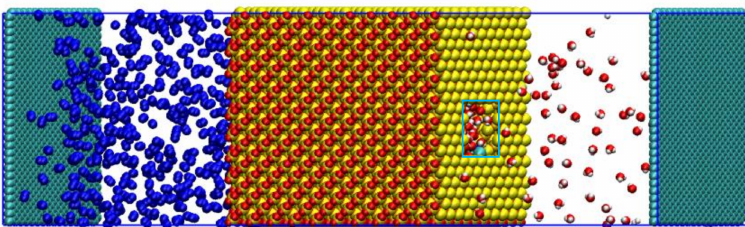
Figure 1. Initial configurations of N 2 in the porous